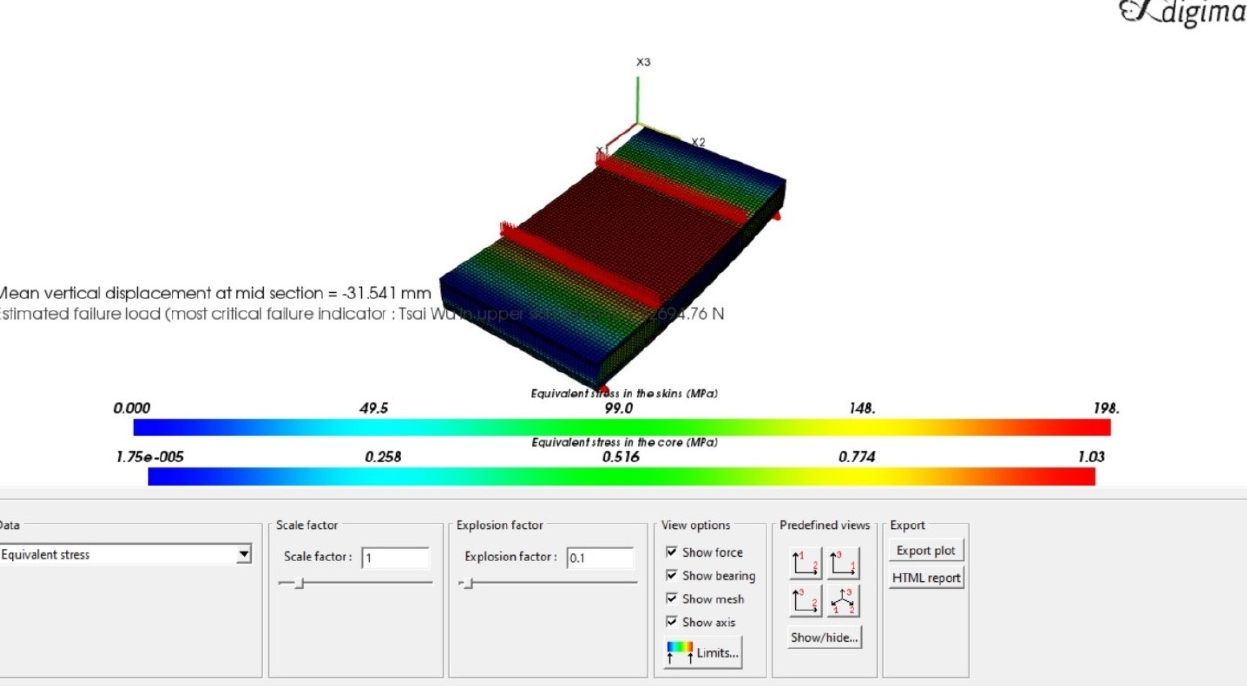
Figure A4. The four-point bending test for the sandwich plate of the helicopter floor numerical model. FRP composite honeycomb core ( t c = 85 mm) and hybrid face sheets ( t f = 1.1